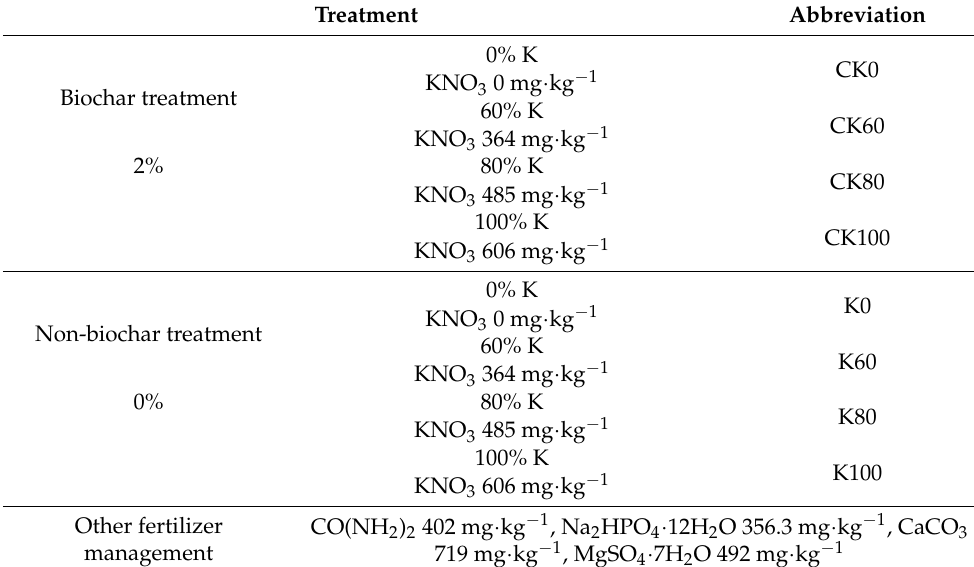
Table 2. Overview of the experimental plan and design. Treatment Abbreviation